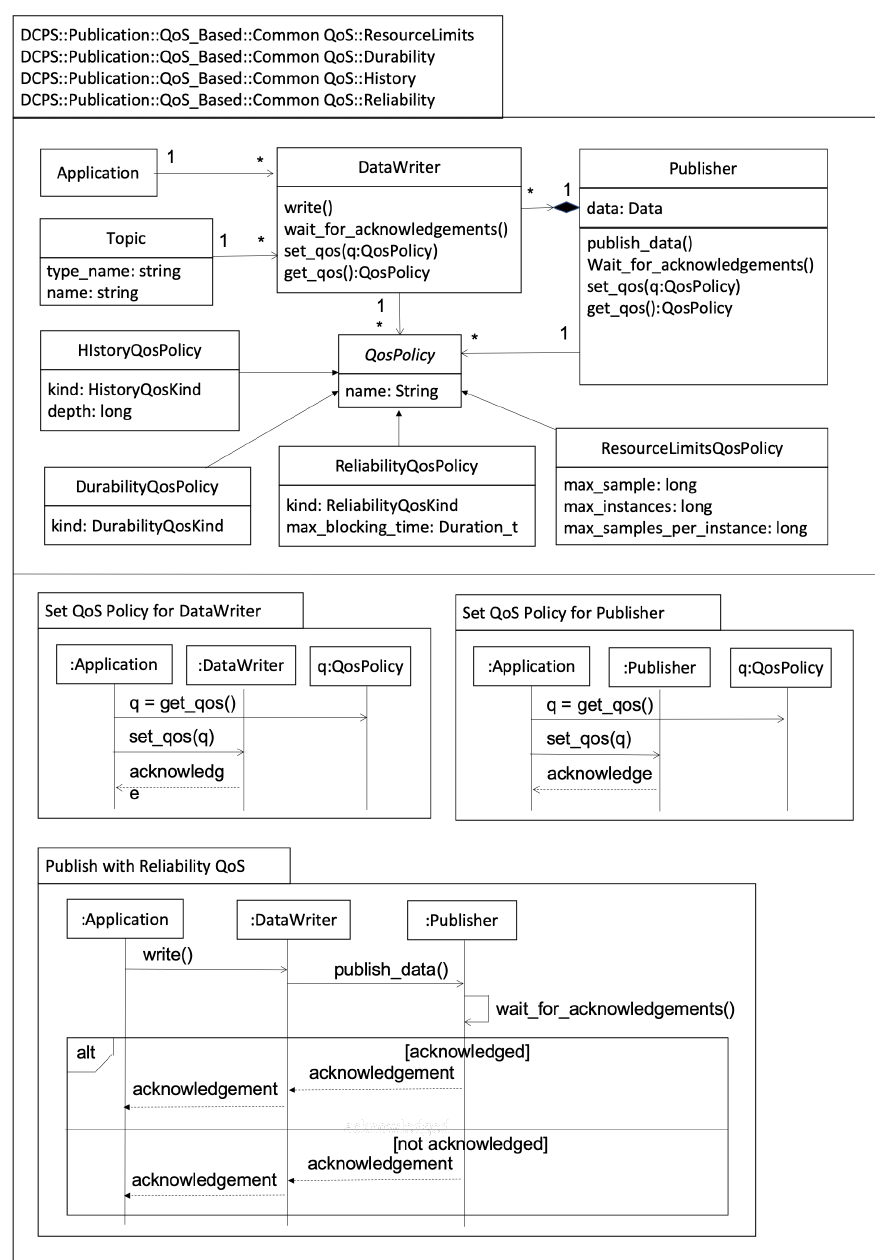
Figure 20. The cf2